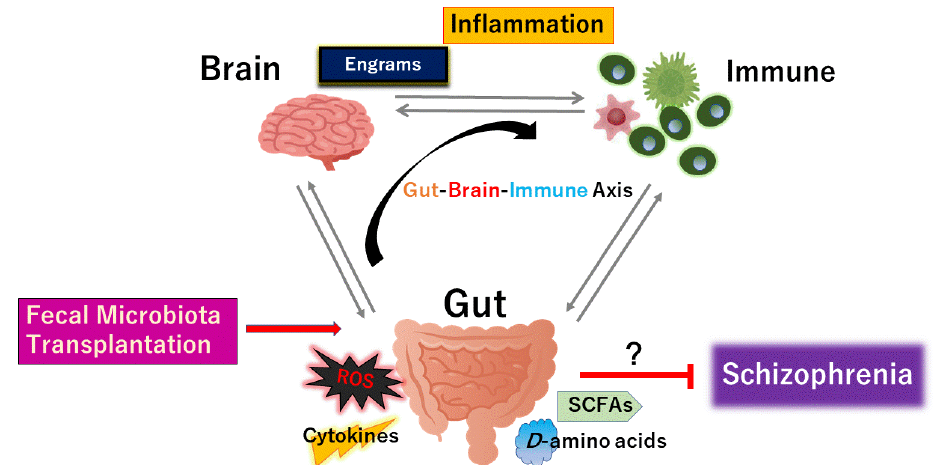
Figure 3. The gut microbiota could promote to the favorable creation of the cytokines, ROS, SCFAs, and certain D -amino acids against disease-progression of schizophrenia. Fecal microbiota transplantation is made up of fecal microbiota infusion from a healthy donor into a recipient subject, which has been likely more successful than just conventional pharmacotherapy for schizophrenia. Arrowhead suggests stimulation whereas hammerhead indicates inhibition. Note that some critical events such as cytokine-induction signaling have been omitted for